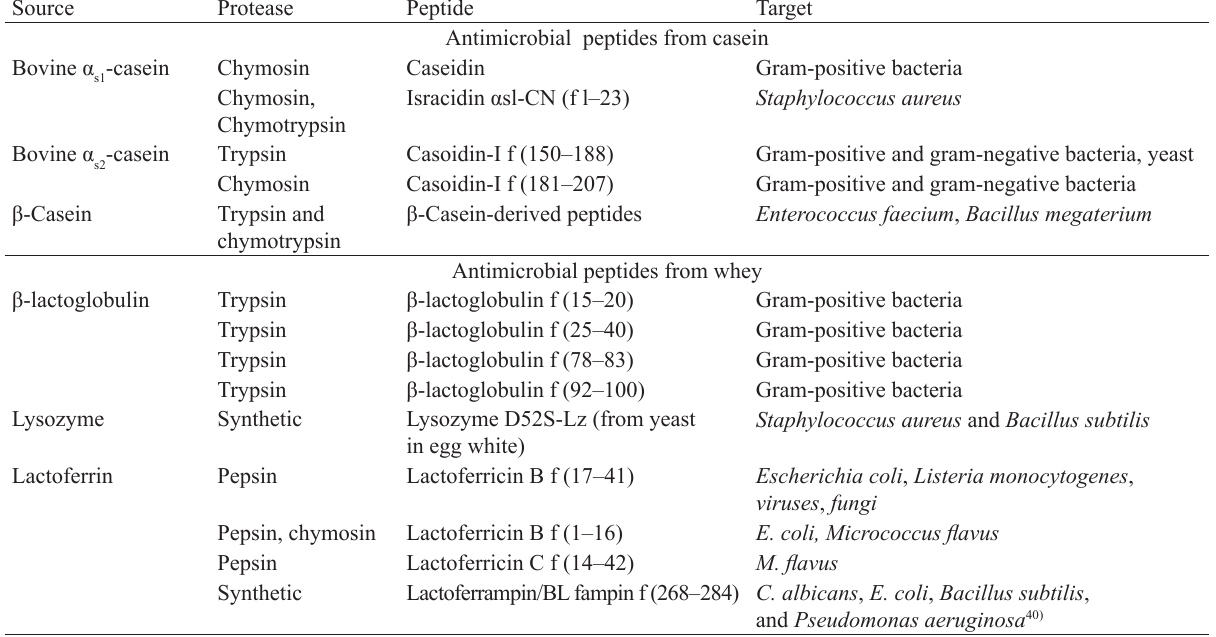
Table 1 Antimicrobial peptides in milk Source